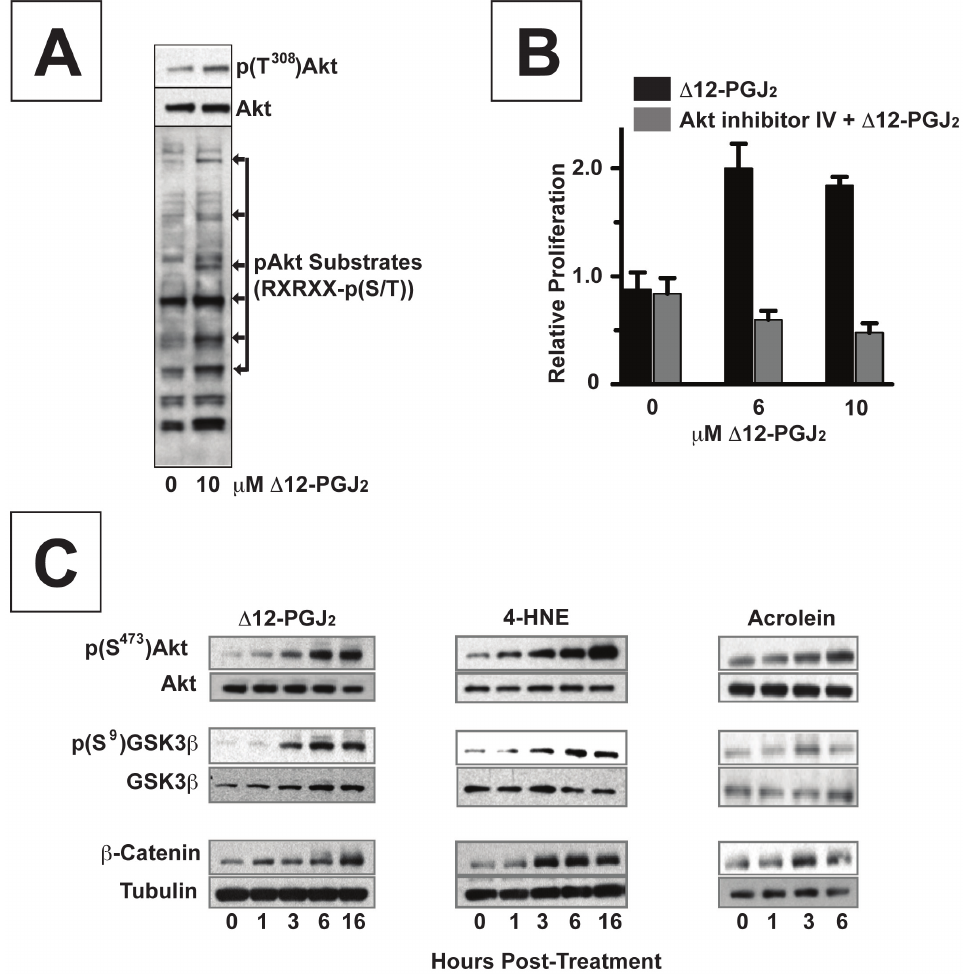
Figure 4. a , ß–unsaturated carbonyls interferes with Akt kinase and downstream signaling in MCF7 and HEK 293 cells. ( A ) Immunoblots of phospho-(T 308 )Akt, total Akt, and several phosphoproteins with (K/R)-x-(K/R)-xx-(S/T), a motif recognized and phosphorylated by active phospho-(T 308 )Akt, in lysates from MCF-7 cells treated 0 and 10 m M D 12-PGJ 2 . ( B ) Relative proliferation of MCF-7 cells (mean 6 s.e.m, n=4) treated with 0, 1, and 10 m M D 12-PGJ 2 alone ( & ), or in the presence of 10 m M of inhibitor IV ( & ), an Akt kinase inhibitor. ( C ) Immunoblots of phospho-(S 473) Akt, total Akt; phospho(S 9 )GSK3 b , total GSK3 b ; and b -catenin and tubulin in lysates from HEK 293 cells after treatment for 0,1, 3, 6 and 16 hrs with 6 m M D 12PGJ 2 , 6 m M 4-HNE or 20 m M acrolein. For (A) and (C), blots are representative of results obtained in three independent experiments.